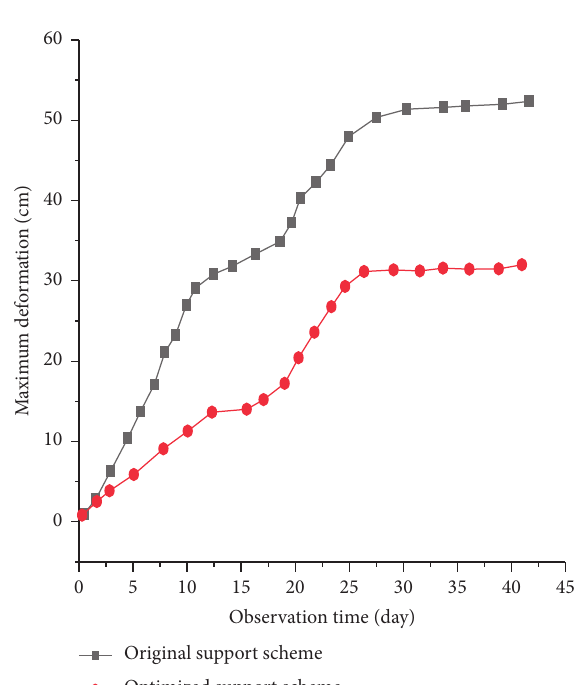
Figure 10: Tunnel surrounding rock deformation by optimized